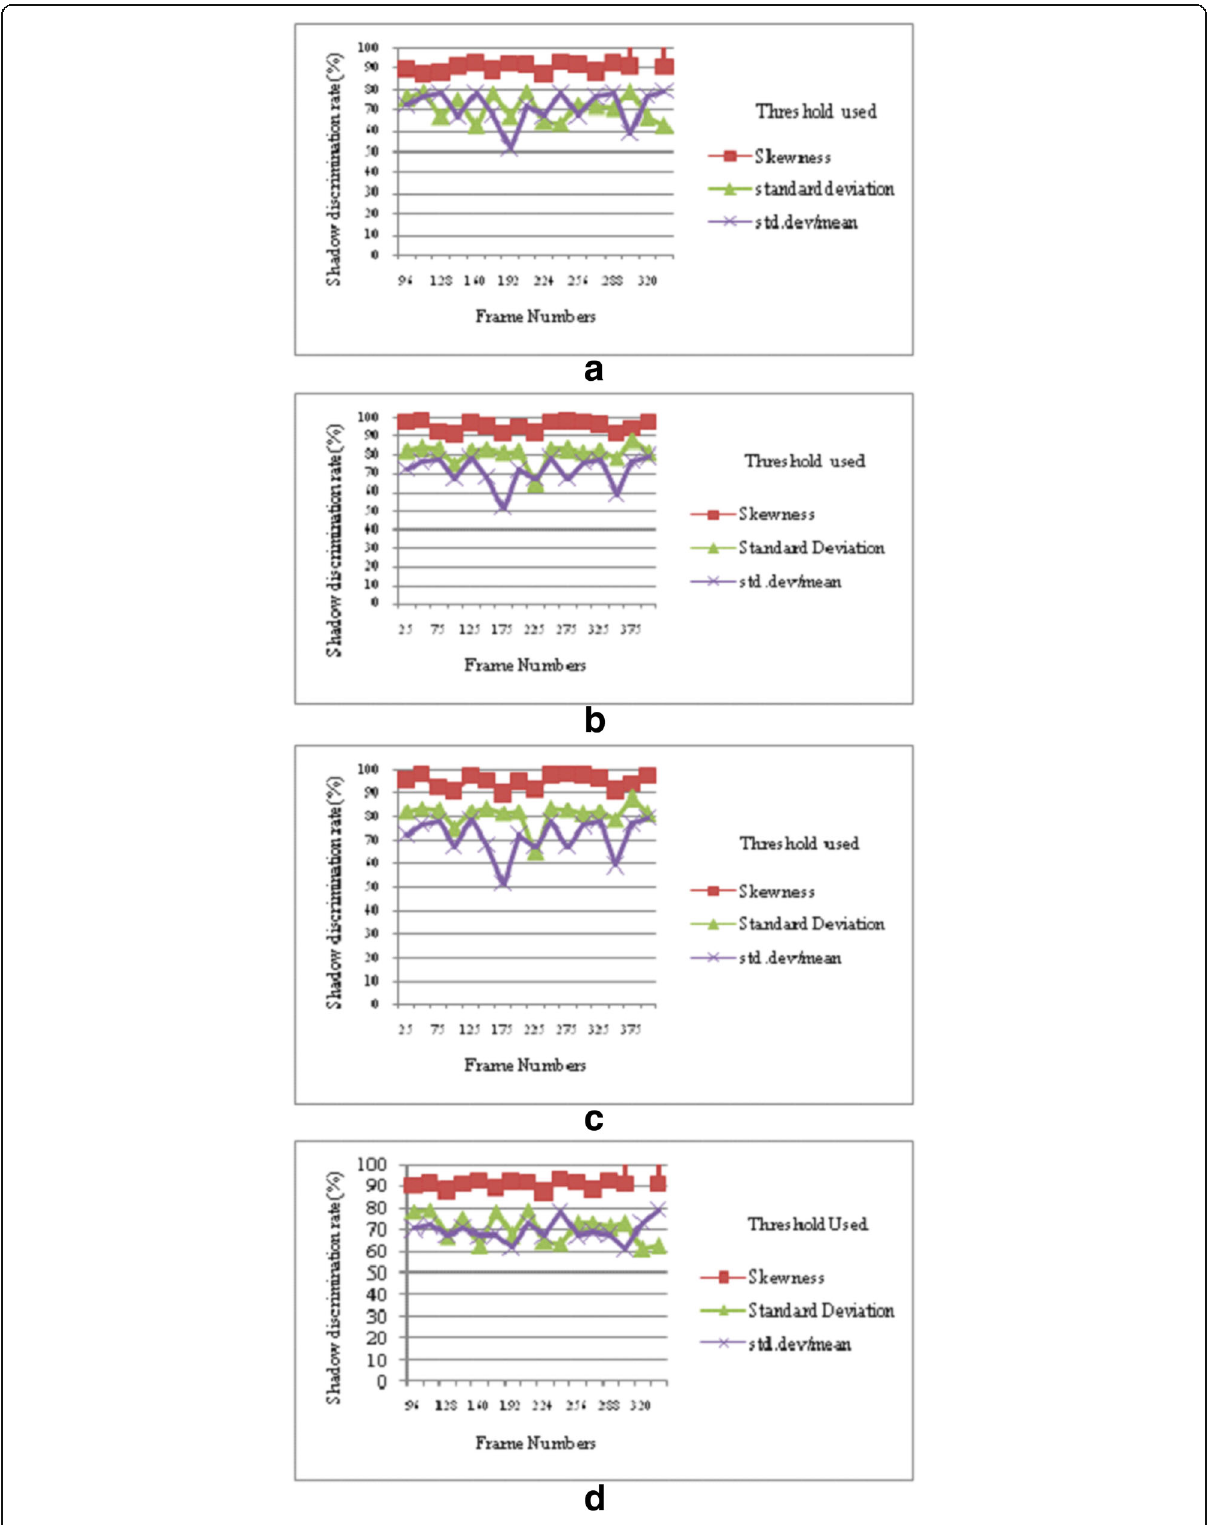
Fig. 6 Shadow discrimination rate of various videos using skewness (proposed method), standard deviation [26] and relative standard deviation [27]. a Shadow discrimination rate in Highway I sequence. b Shadow discrimination rate in Shopping Mall. c Shadow discrimination rate in “ Sarvam ” regional movie song. d Shadow discrimination rate in Lobby